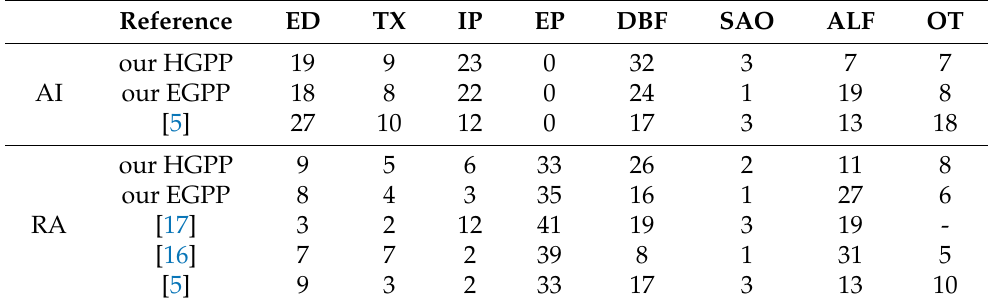
Table 9. Comparison of the computational load distribution (in %) among functional blocks for different VVC decoder